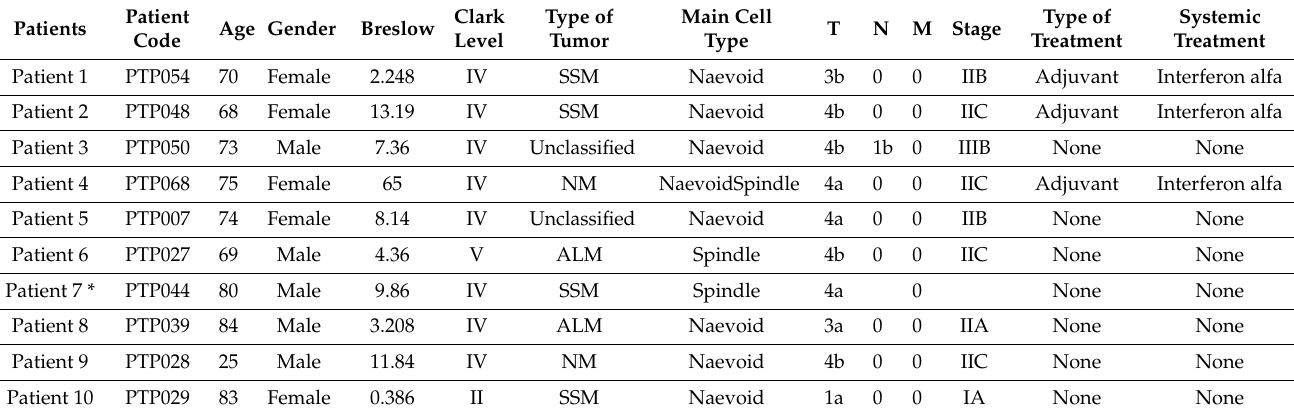
Table 2. Clinicopathological data of the 10 MM patients. Primary tumor samples from the 10 MM patients were submitted for histopathological characterization after tumor resection. T, N, M system classification: T (Primary tumor), N (Regional Lymph Nodes, M (Distant